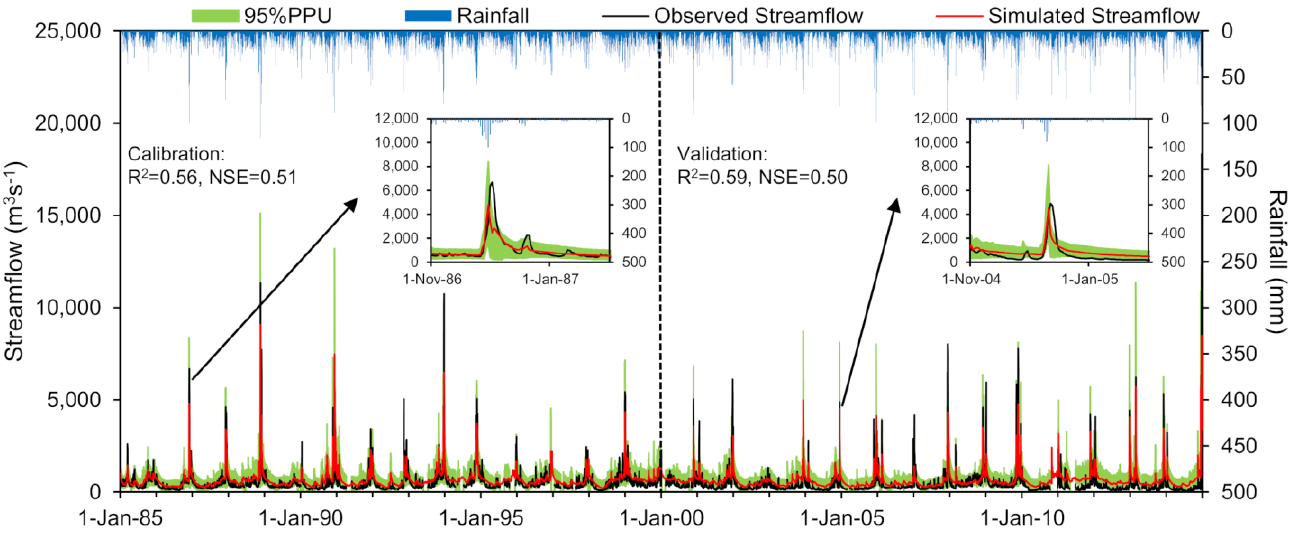
Figure 3. Observed and simulated daily streamflow at Jambatan Guillermard from 1985 to 2014.